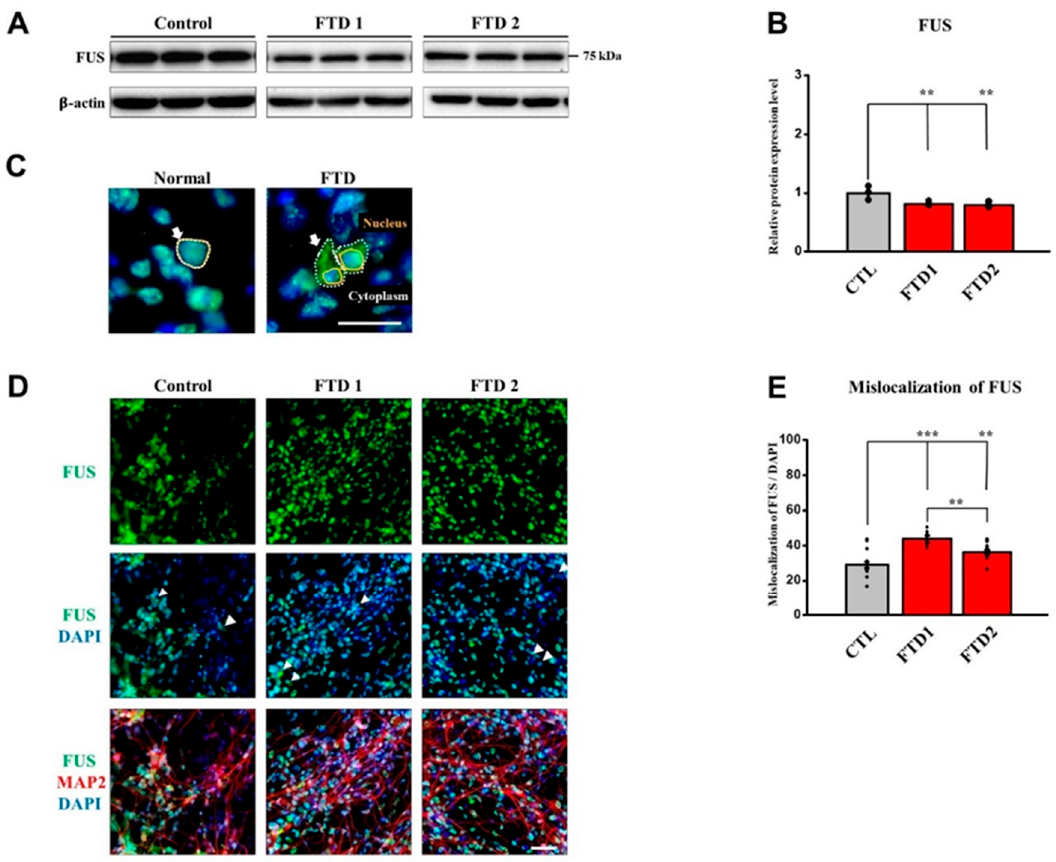
Figure 6. Abnormal expression patterns of FUS proteins in the bvFTD iPSC-derived neurons. ( A ) Immunoblot assay showing FUS expression. β -actin was used as a loading control. Note that blot images indicated by dividing lines were chosen from di ff erent immunoblots due to the large size of samples. Protein quantifications were conducted under the same exposure time. Whole blot images are provided in Supplementary Figure S4D. ( B ) Quantification of immunoblot assay showing that total FUS expression levels were decreased in the two bvFTD iPSNs ( n = 3) (*: vs. normal control) * p < 0.05, ** p < 0.01, and *** p < 0.001, one-way ANOVA. ( C ) Simple description of mis-localized FUS expression. Scale bar: 100 µ m. ( D ) Immunocytochemical assay showing the expression of FUS (green) and MAP2 (red), which were counter-stained with DAPI (blue), in the iPSC-derived neurons at three weeks of neuronal di ff erentiation. Scale bar: 50 µ m. ( E ) Quantification of immunocytochemical assay using the translocation module in the MetaXpress ® 6 program. Note that mis-localized FUS expression against the nucleus was increased in the two bvFTD iPSCNs, bvFTD1 ( p < 0.0001) and bvFTD2 ( p = 0.0029) ( n = 16) (*: vs. control) * p < 0.05, ** p < 0.01, and *** p < 0.001, one-way